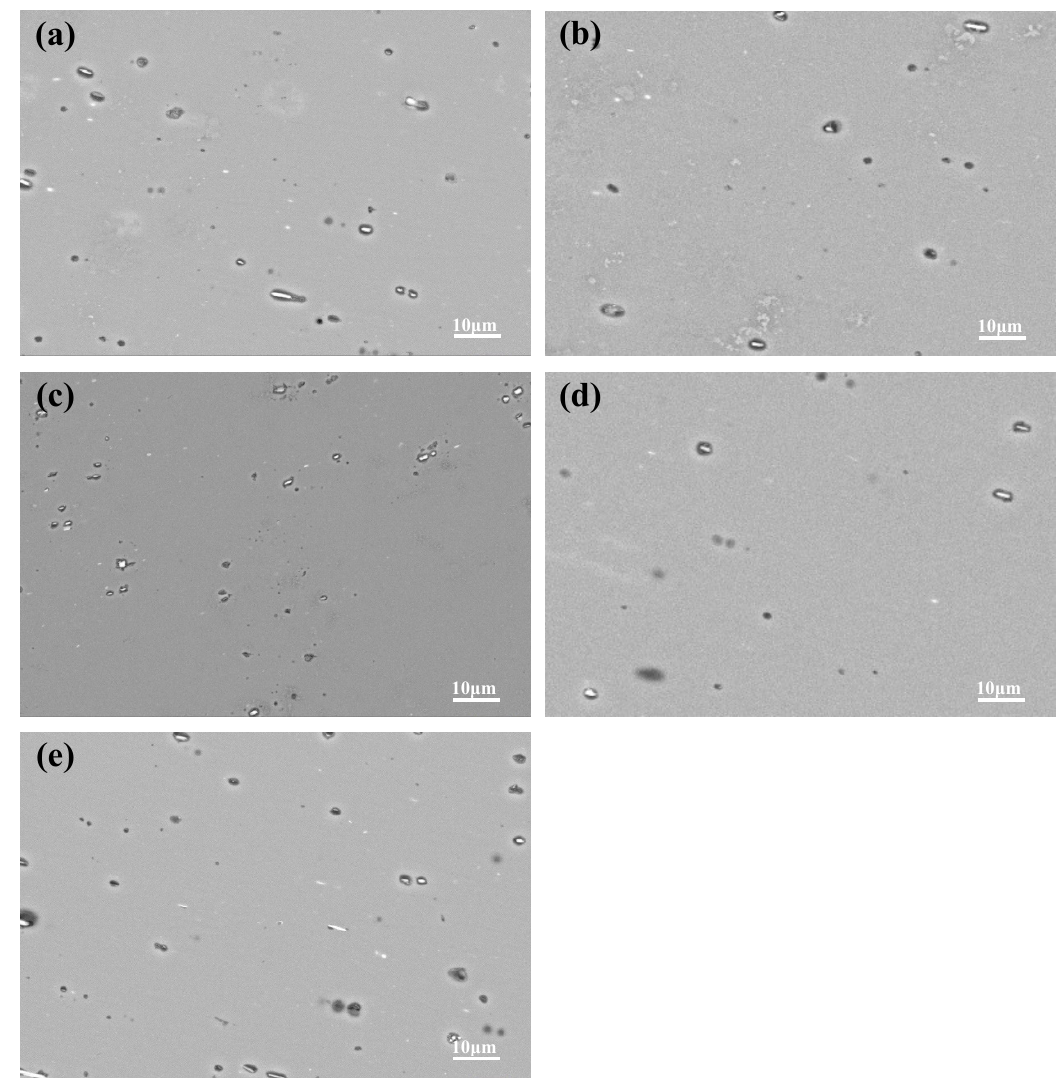
Figure 8. Representative corrosion surface morphologies of the five aged samples immersed for 1 min in IGC solution representing: ( a ) A1, ( b ) A2, ( c ) PA, ( d ) PCA, ( e ) PDA.